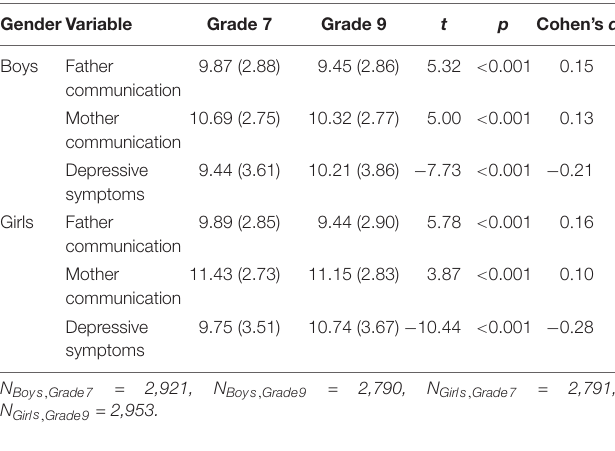
TABLE 5 | Effect of father-adolescent and mother-adolescent communication on adolescents’ depressive symptoms. TABLE 6 | Moderating effect of adolescents’ grade and gender on the relation